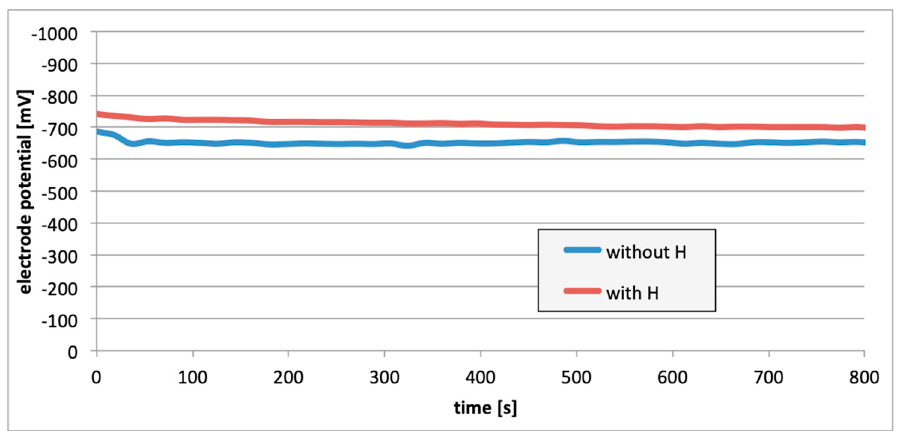
Figure 8. Electrode potential change after the alloy hydrogenation (EN AW-5754).